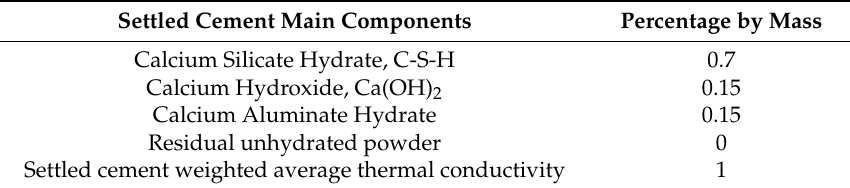
Table 3. Example of Class G hardened cement main